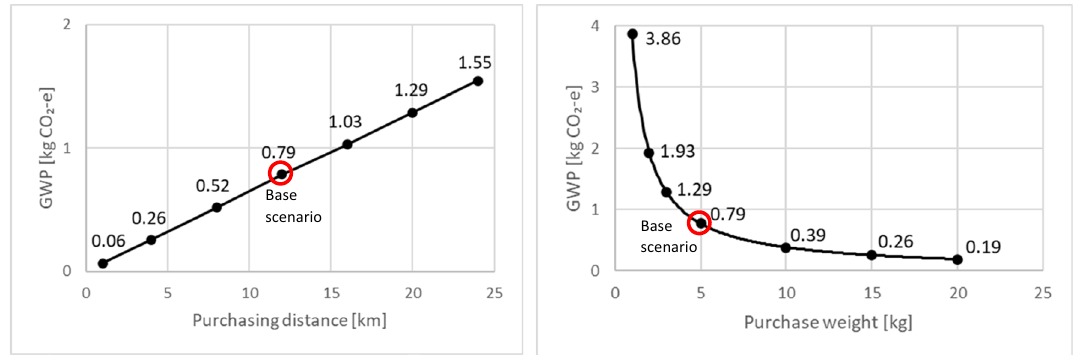
mile only) and constant purchase weight (5 kg). Right: Sensitivity analysis of the purchase weight: GWP when traveling the last mile by car with a varying purchase weight (1, 2, 3, 5, 10, 15 and 20 kg) and a constant purchase distance (12 km) (phase last mile